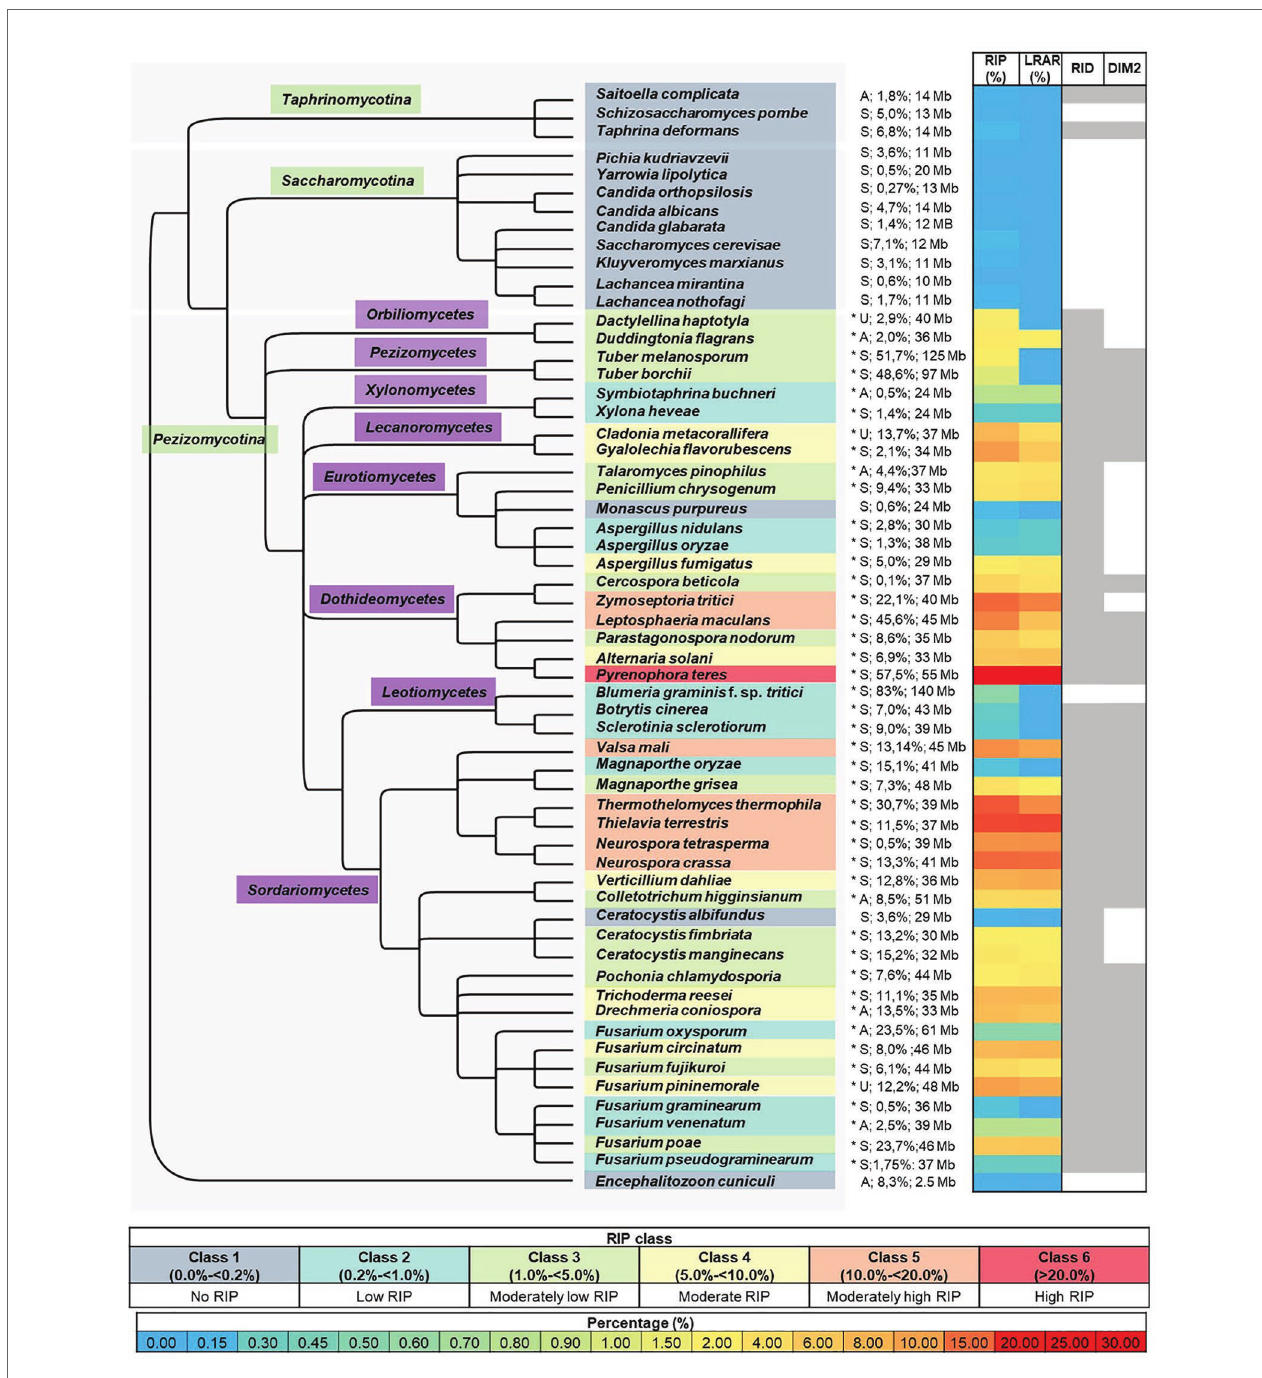
FIGURE 1 | Summary of genome-wide RIP analyses of Ascomycota investigated in this study. From left to right, the first panel represents a cladogram that summarizes the phylogenetic relationships among the fungi investigated, with the microsporidian fungus En. cuniculi serving as the root. An asterisk following species names denotes species where a chi-square test indicated that the frequency of RIP-positive windows in the simulated data and that of the actual genome studied differed significantly ( p < 0.01 confidence level). The panel following the asterisk shows reproductive strategy (“A,” “S,” and “U,” indicating asexual, sexual, and unknown), the predicted proportion (%) of the genome that is repetitive, and genome size [Megabases (Mb)]. The next panel represents a heatmap that illustrates the total proportion (%) of each genome assembly that constitutes RIP mutations and large RIP affected regions (LRARs). The last panel (right) indicates the presence/absence of the RIP-associated genes RID and DIM-2 in each genome (for the latter, see Supplementary Table S3 and Supplementary Figure S1 for detail about these two genes, as well as those for other RIP-associated genes), where shaded columns indicate that a putative homologous sequence identified. The color coding used in the different panels is explained in the keys